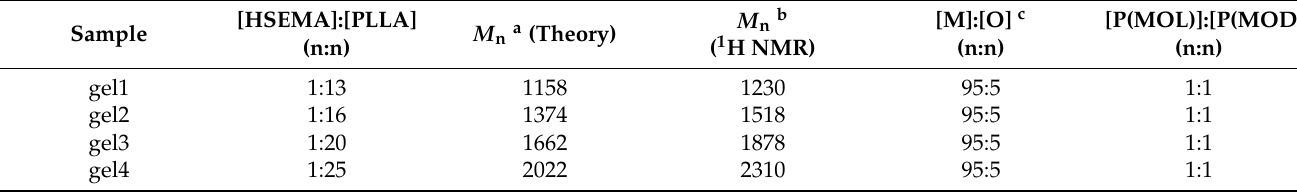
Table 1. The adding data of each reaction material. Sample